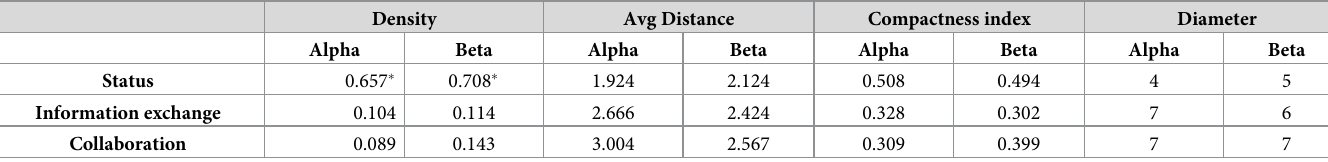
Table 3. Cohesive metrics [22].